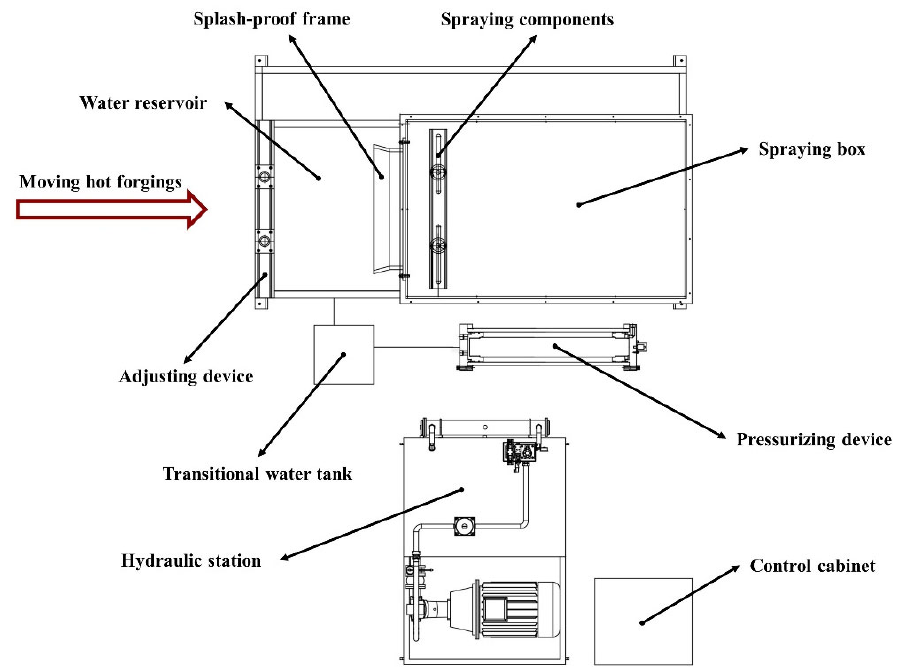
Figure 5. A schematic diagram of the descaling experimental setup.